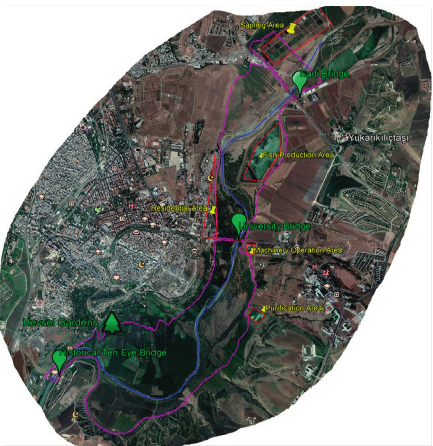
Figure 7: Flood boundary with HEC-RAS ( Q